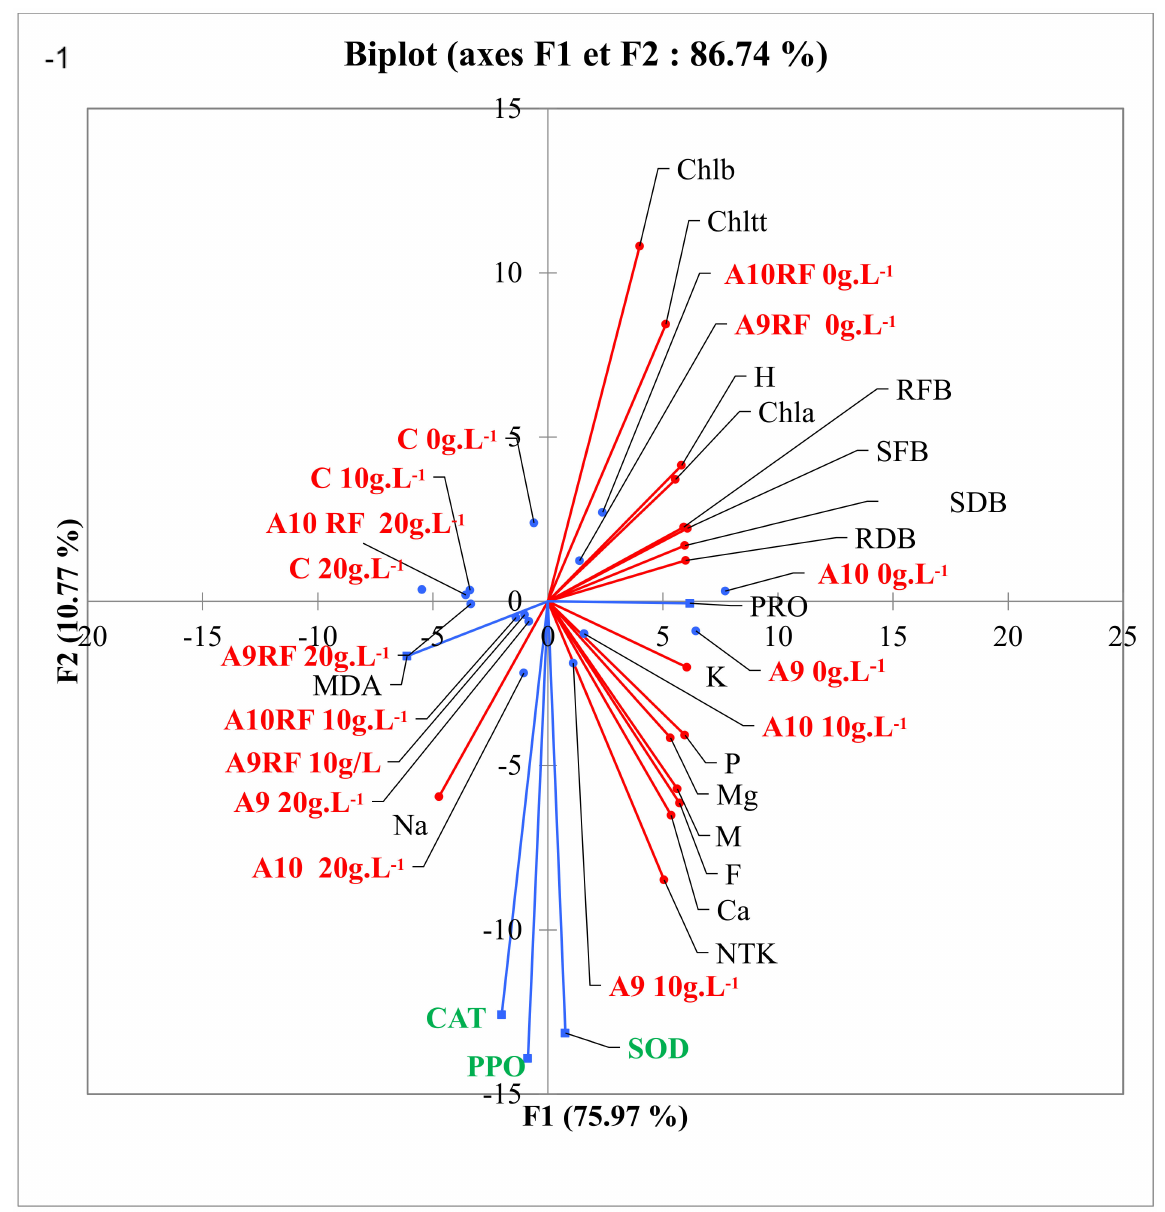
Figure 4. Graphical representation of the principal component analysis (PCA) of the correlation between the effects of AMF inoculants on growth, nutrition, protein, and MDA synthesis and oxidative enzyme activity of ten-month aged date palm seedlings under salt stress. A1, A4, A7, A9, A10 are arbuscular mycorrhizal fungi complexes; A1RF, A1RC, A4RF, A7RN, A9RF, A10RF are arbuscular mycorrhizal fungi monospecific isolates. H: Height; SFW: Shoot fresh biomass; SDB: Shoot dry biomass; RFB: Root fresh biomass; RDB: Root dry biomass; PRO: Protein contents; C: Control without arbuscular mycorrhizal